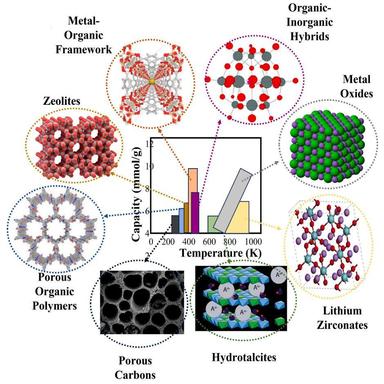
Porous solid adsorbents and their potential capacities.